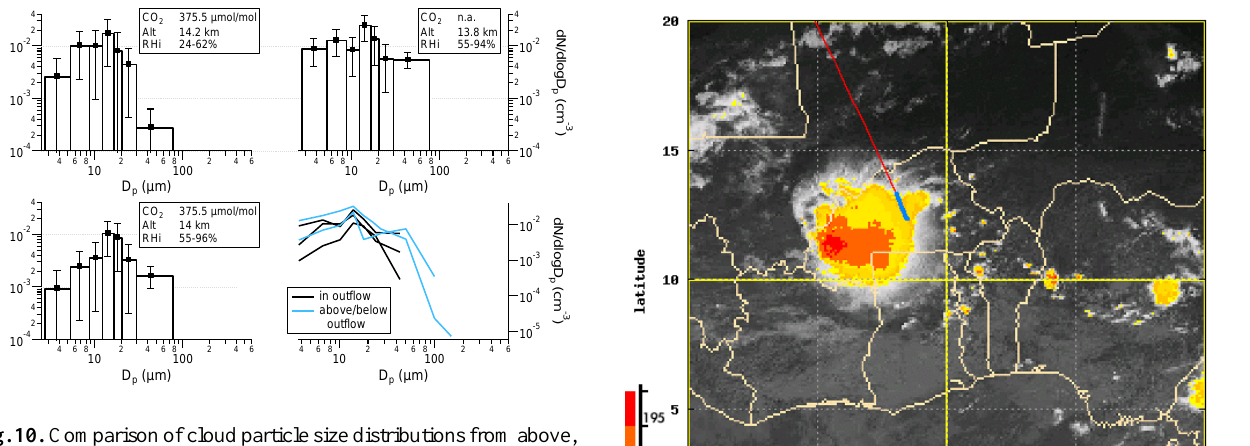
Fig. 10. Comparison of cloud particle size distributions from above, inside and below the aged outflow on 11 August 2006. The three black curves in the lower right panel show the single size distri- butions of the other panels for a better comparison along with one size distribution from a higher and one from a lower level than the outflow.